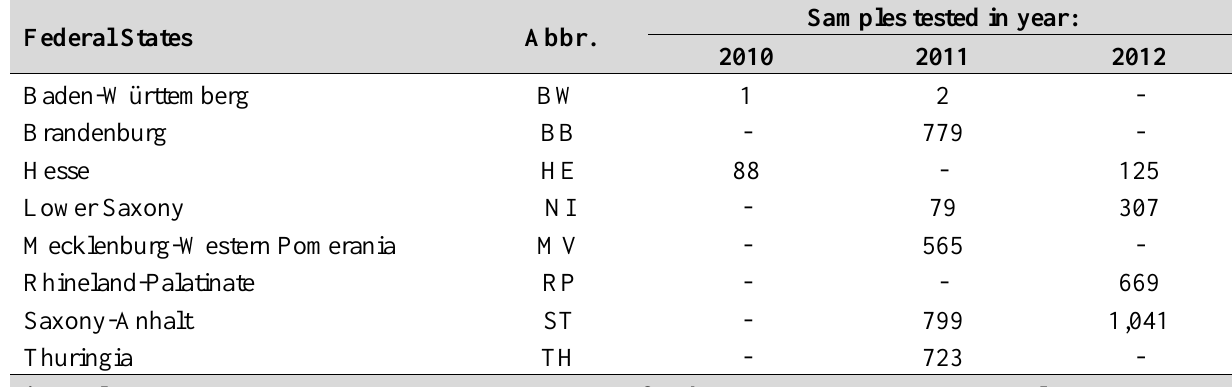
Table 1. Total number of horse sera sampled in Germany from 2010 till 2012.